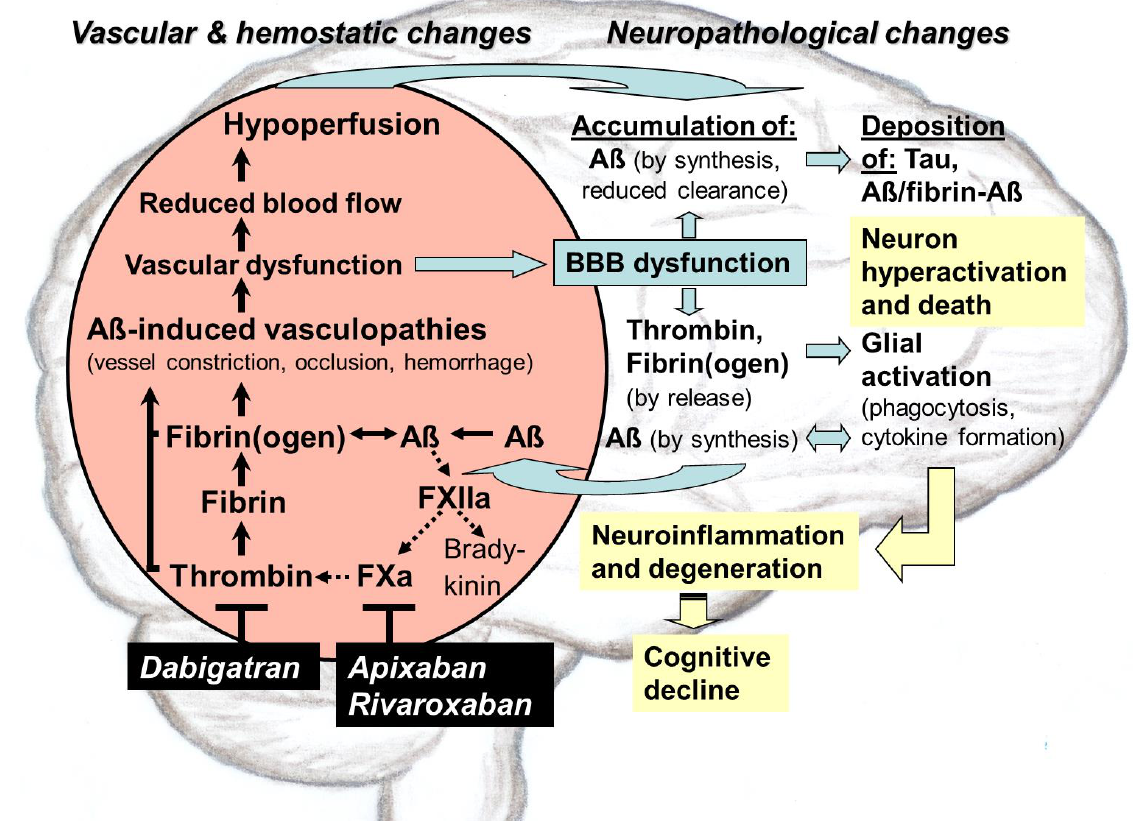
Figure 1. Mechanism of action of direct oral anticoagulants (DOACs) in therapeutic treatment of vascular abnormalities, triggered by thrombin, a key factor in Alzheimer´s disease (AD). In addition to the accumulation of toxic tau and amyloid-ß proteins (Aß) in brain parenchyma, excessive pro- duction of thrombin in the blood, leading to fibrin formation; degradation-resistant, Aß-containing fibrin(ogen) clots; and inflammatory milieu are an early and typical hallmark of AD. Particularly in hippocampal and neocortical parenchyma, the release of Aß into the blood triggers the synthesis of thrombin and proinflammatory bradykinin. Aß activate blood coagulation factor XII to generate FXIIa in the plasma contact system. Thrombin, which is produced from prothrombin by the pro- thrombinase complex via factor Xa (FXa), catalyzes the conversion of fibrinogen to fibrin and induces, together with fibrin(ogen), platelet aggregation, which can lead to vessel occlusion. Deposition of oligomeric Aß and Aß-containing fibrin clots cause vessel constriction and cerebral amyloid angiopathy (CAA). CAA is a major cause in Aß-induced brain vasculopathies and associated lesions, such as vessel occlusion and hemorrhages, leading eventually to vascular and blood–brain-barrier (BBB) dysfunction. As consequences, cerebral blood flow (CBF) and perfusion decrease and supply of brain tissue with oxygen (hypoxia) and nutrients suffer. Concomitantly, Aß increasingly accumulate and aggregates spread in the parenchymal tissue, caused by hypoxia-induced Aß synthesis, as well as by BBB-impaired perivascular Aß clearance. This self-amplifying accumulation of Aß elicits neuronal hyperactivation and synaptic dysfunction and promotes neurotoxic tau pathologies. In addition, BBB dysfunction allows vascular thrombin and fibrin(ogen) to extravasate into the parenchymal tissue and to activate, together with Aß, glial cells, inducing chronic inflammation and further Aß production. In addition, neuronal damage with loss of synapses and neurons is progressing, leading to cognitive decline. DOAC intervention into this vicious circle targets the key mediator thrombin, which can be blocked in its activity by dabigatran or in its production by FXa-inhibitors, such as apixaban, rivaroxaban. Early thrombin inhibition in AD patients could preserve vascular and BBB integrity for full brain perfusion and function. Thereby, vascular-driven neuroinflammation and degeneration and associated cognitive decline could be prevented. Modified from [11].